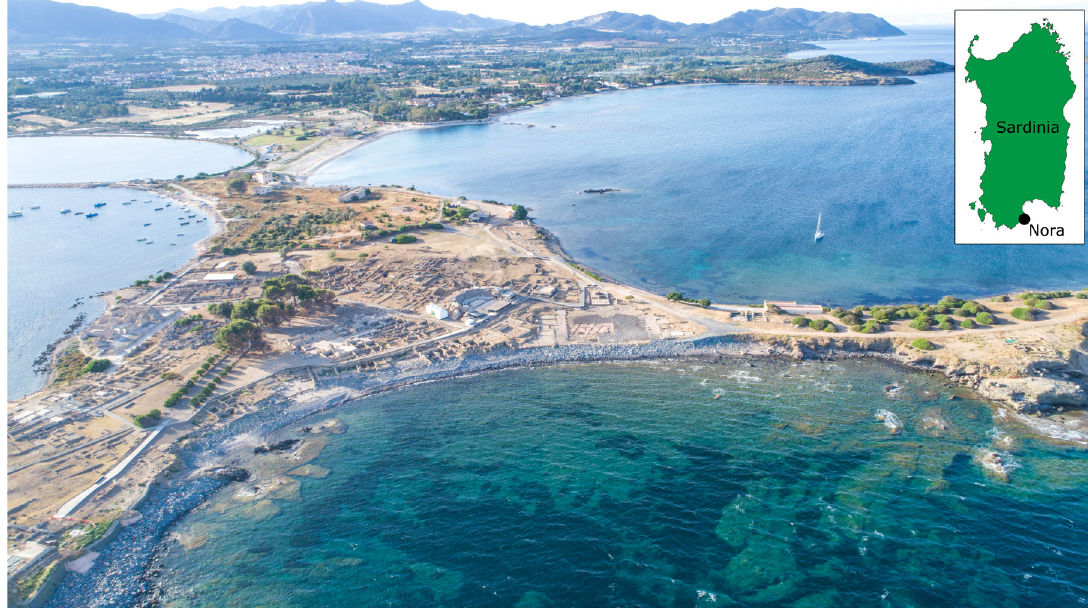
Figure 1. The site of Nora. Location of the archaeological site and overview on the site. Image: M.